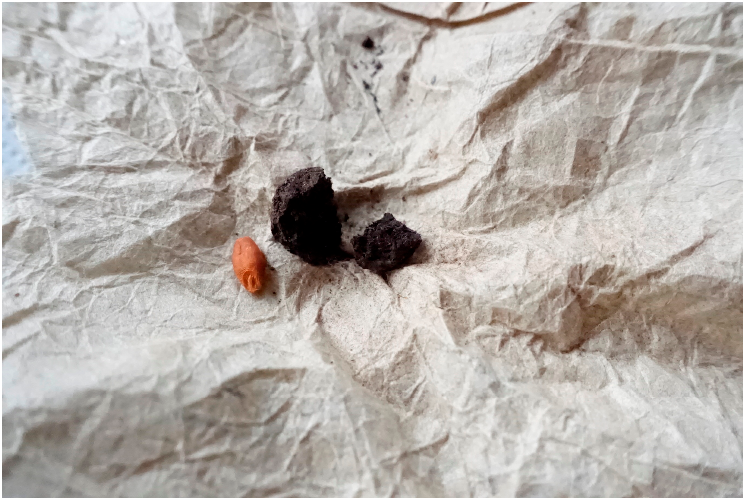
Figure 1. A piece of one of Domo Geshe Rinpoche’s jinten pills, Kalimpong 2018. Photo by author.